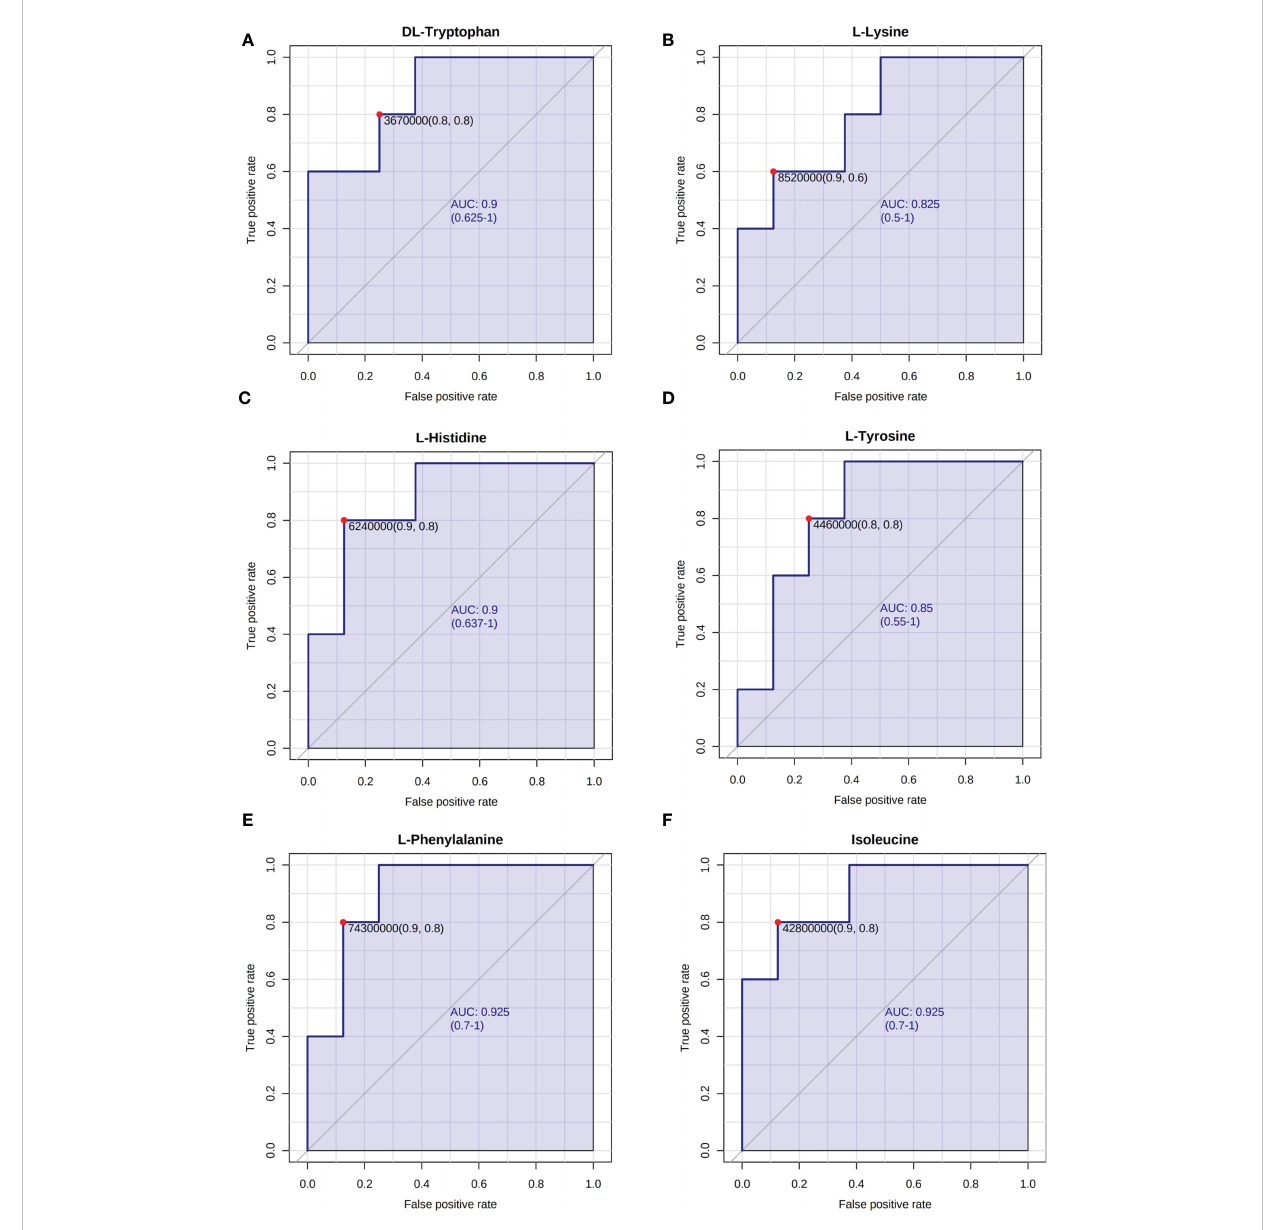
FIGURE 3 ROC analysis of representative differentially expressed metabolites. The AUC of (A) DL-tryptophan, (B) L-lysine, (C) L-histidine, (D) L-tyrosine, (E) L- phenylalanine, and (F)